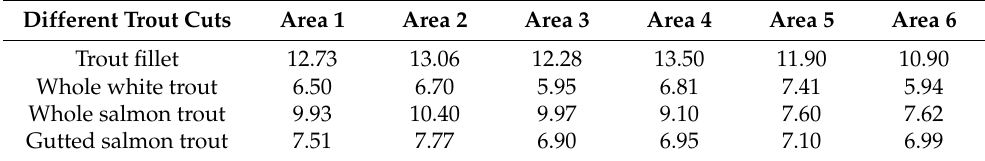
Table 13. Price paid by consumers in different geographical areas of